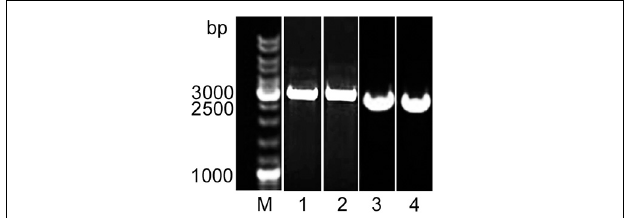
FIGURE 2 | Molecular evidence of the deletion of alpB in Lysobacter XL1. Agarose gel stained with ethidium bromide after the electrophoresis of PCR amplicons produced with primers L5_ Sac I(for) and L5_ Xho I(rev). The PCR amplicon for the mutant allele is 3,177 bp long (including alpB flanking sequences + the TcR cassette), whereas the wild-type allele produces a 2,623-bp product (including the full-length alpB gene + adjacent regions). M, SM0331 GeneRuler DNA Ladder Mix (Thermo Fisher Scientific, United States) (lane taken from Supplementary Figure 3 ); (1) Lysobacter sp. XL1 (cid:49) alpB::tet clone (from Supplementary Figure 2 ); (2) pJQ200SK (cid:49) alpB::tet plasmid (from Supplementary Figure 2 ); (3) Lysobacter sp. XL1 (cid:49) alpB::alpB clone (from Supplementary Figure 3 ); and (4) Lysobacter sp. XL1 clone (from Supplementary Figure 3 ).